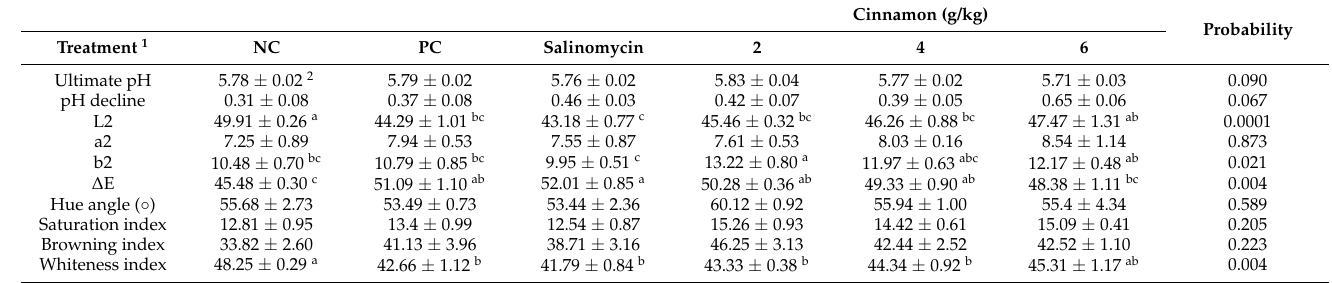
Table 4. pH, and color of the pectoralis major at 34 d of age in broilers fed diets containing varying amounts of cinnamon bark powder (CBP) were measured 24 h